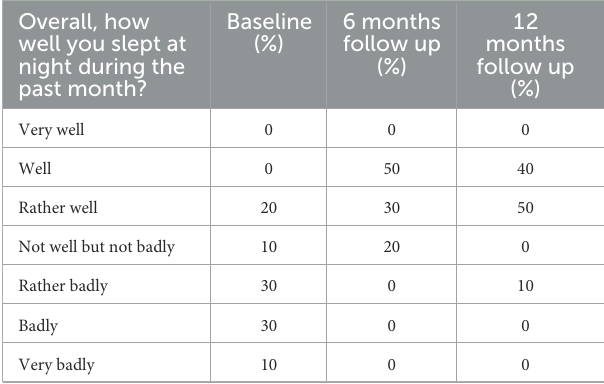
TABLE 4 Evolution of overall item (C1—“Overall, how well you slept at night during the past month?”) in SCOPA-SLEEP. Scores are shown in